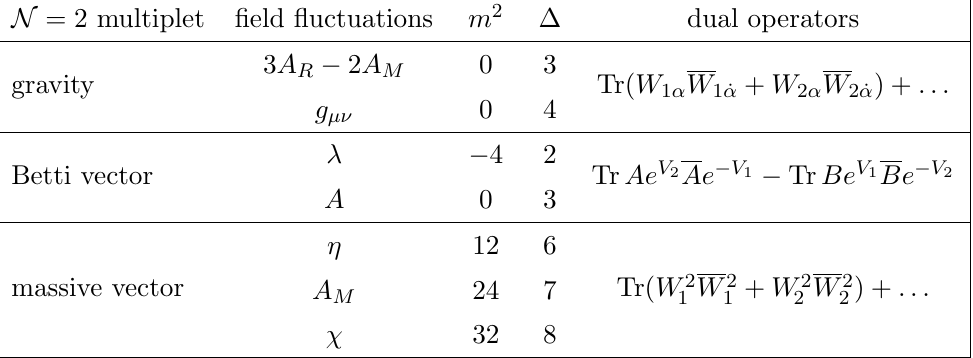
Table 1 . Mass eigenstates of the type IIB supergravity truncation introduced here on the super- symmetric AdS 5 (cid:2) T 1 ; 1 background, and their dual super(cid:12)eld operators, adapted from